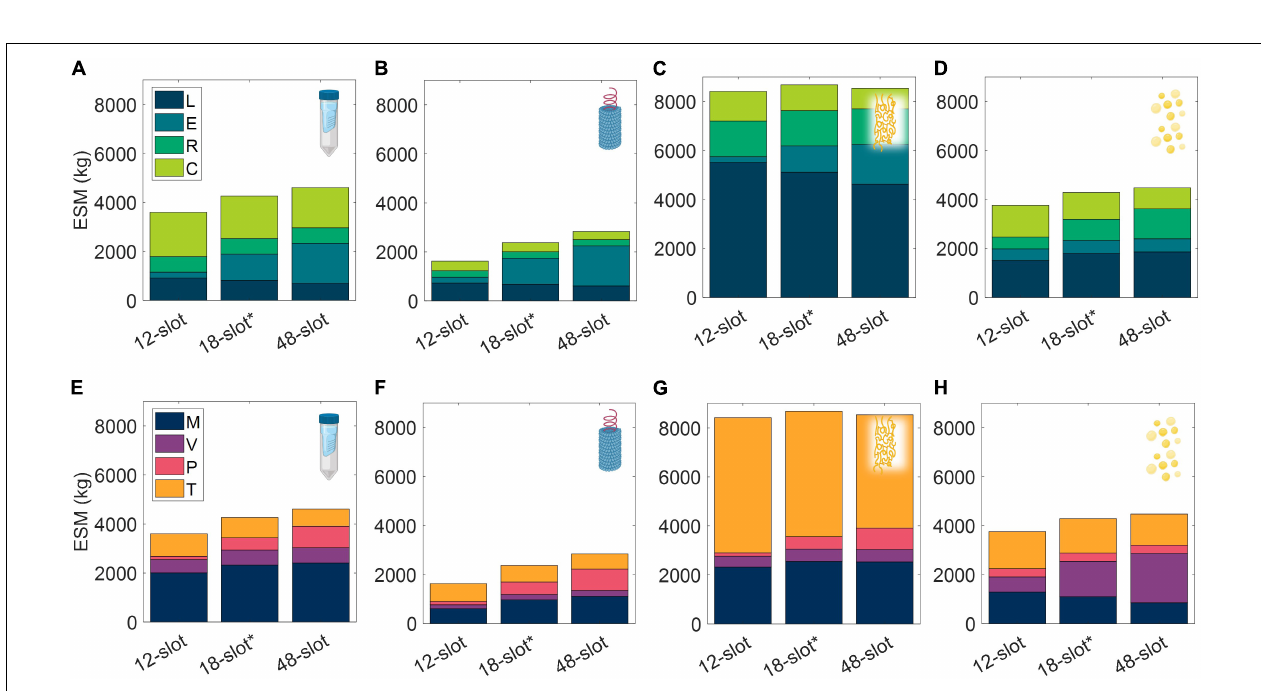
FIGURE 9 | Changes in extended equivalent system mass values with different capacity centrifuge models broken down by labor (L), equipment (E), raw materials (R), and consumables (C) cost categories and mass (M), volume (V), power (P), and labor time (T) constituents for SPN (A,E) , VIN (B,F) , ELP (C,G) , and OLE (D,H) . SPN, spin column; VIN, plant virus-based nanoparticle; ELP, elastin-like polypeptide; OLE, oilbody-oleosin.